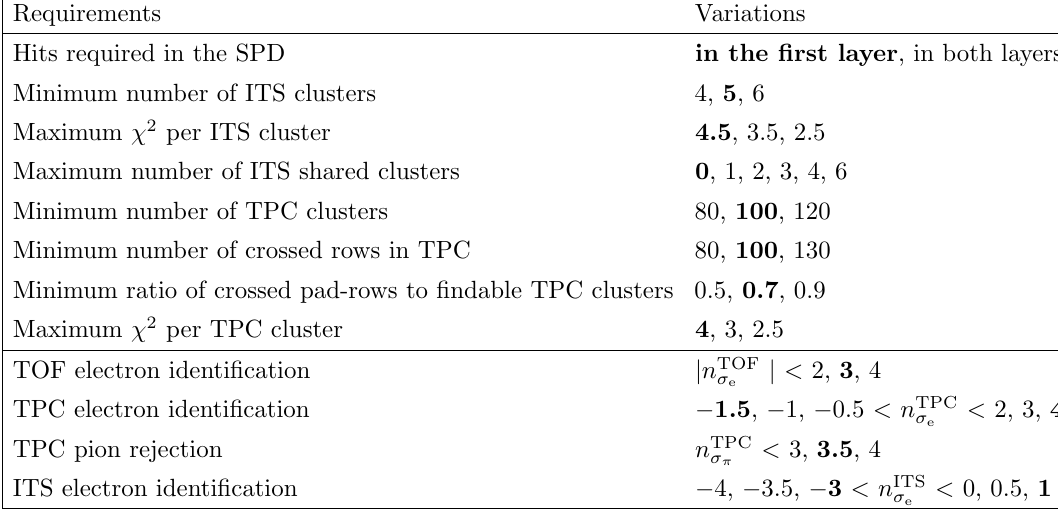
Table 1 . Summary of the single-track selection criterion variations to determine the systematic uncertainties. The default values are shown in